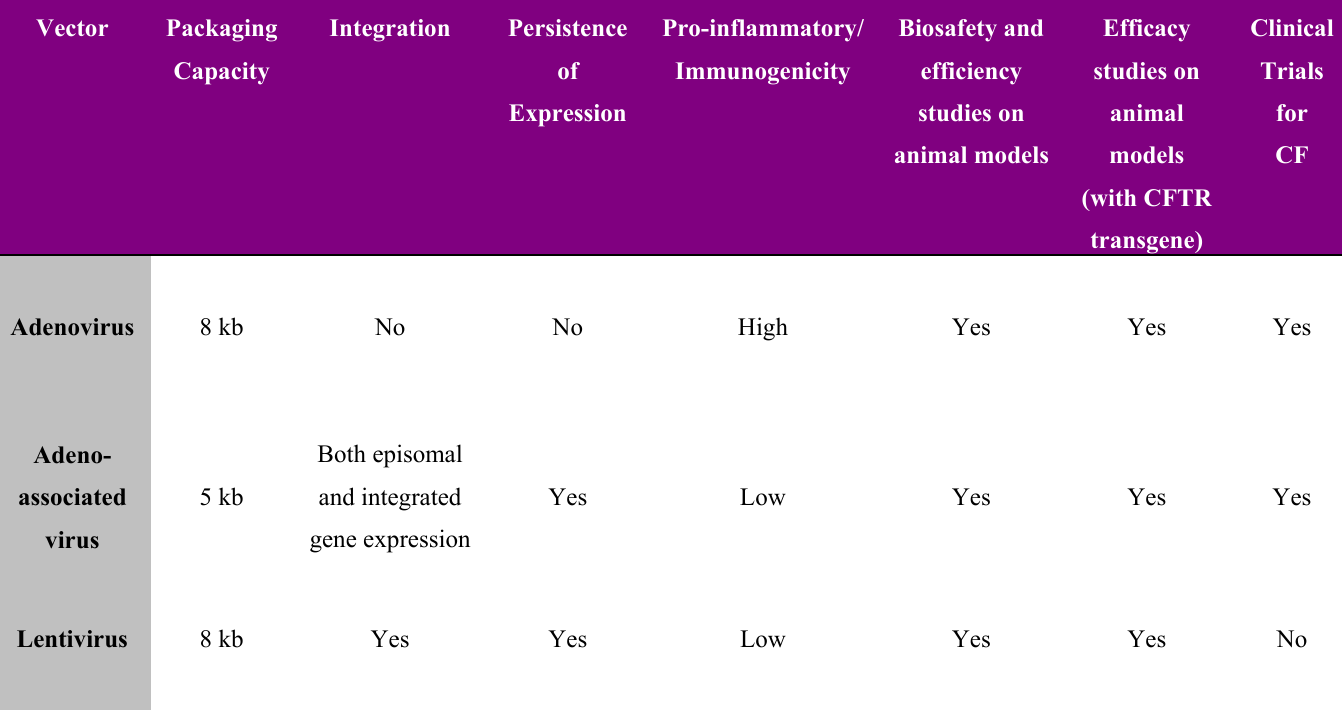
Table 1. Comparison among viral vectors for CF gene